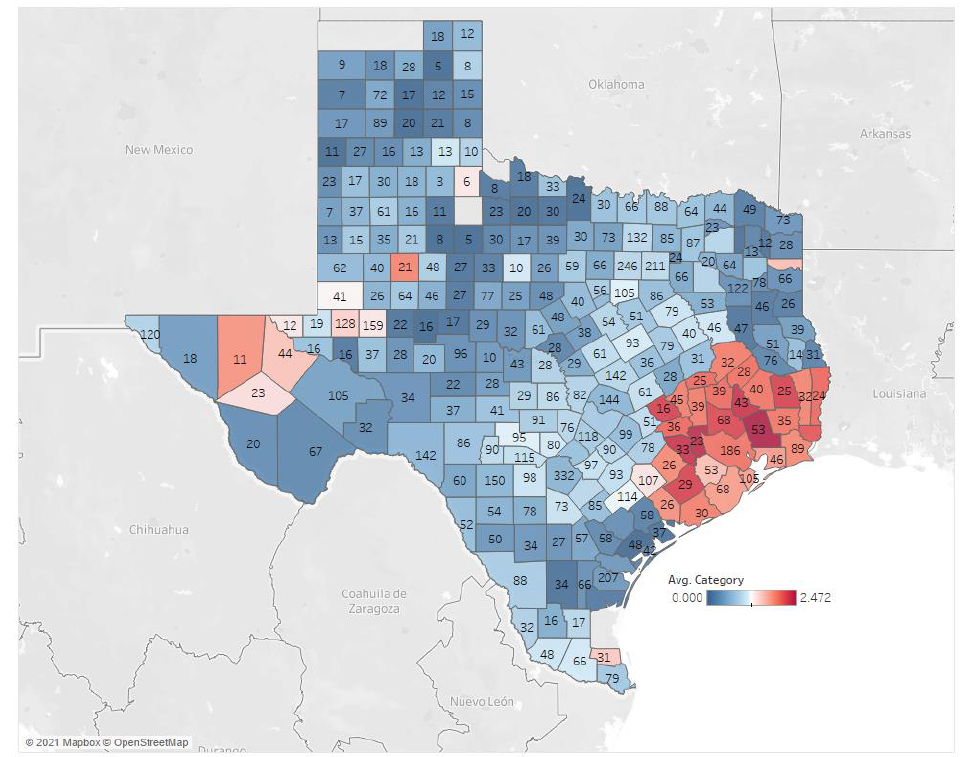
Figure 3. Spatial distribution of the number of records and the average FRI over different counties in the state of Texas.